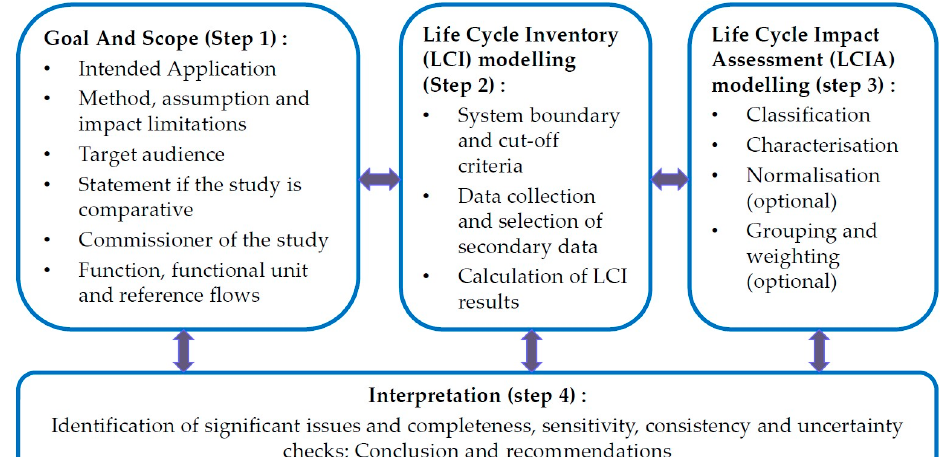
Figure 1. Life cycle assessment (LCA) framework (adapted from ISO 14040:2006 [1]).